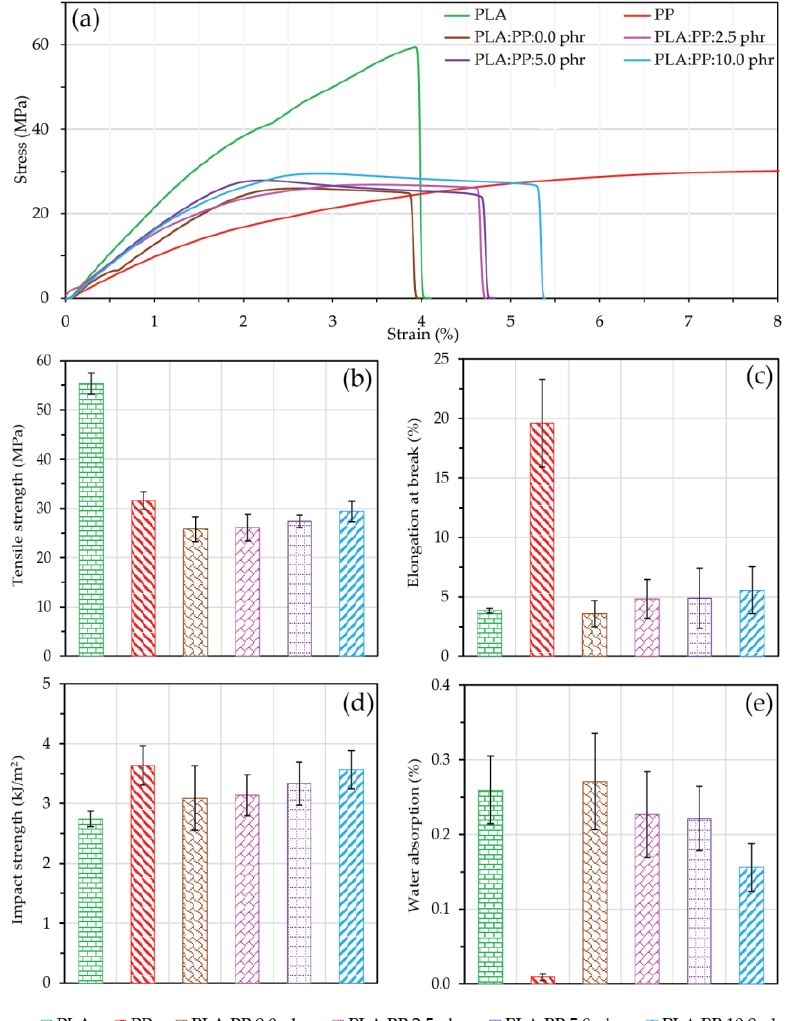
Figure 5. Physical properties of PLA, PP, and PLA/PP (70:30 wt%) blends with LNR−g−MMA of 0.0, 2.5, 5.0, and 10.0 phr: ( a ) stress–strain curves, ( b ) tensile strength, ( c ) elongation at break, ( d ) impact strength, and ( e ) water absorption. The error bars indicate the standard deviation.